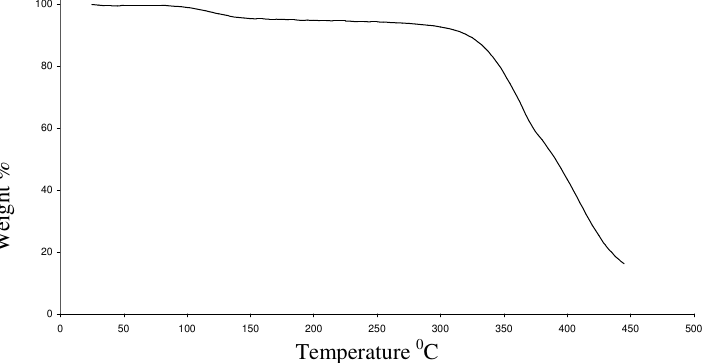
Figure 5. TG curve of epoxy acrylate with EOPA sample R